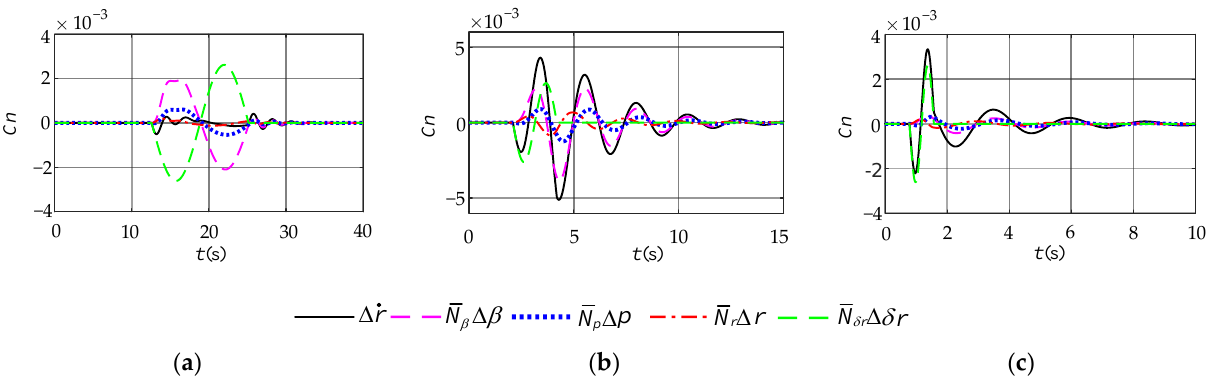
12 of 26 Figure 9. Amplitude–frequency characteristic curve of the yawing moment component with the change in rudder frequency.